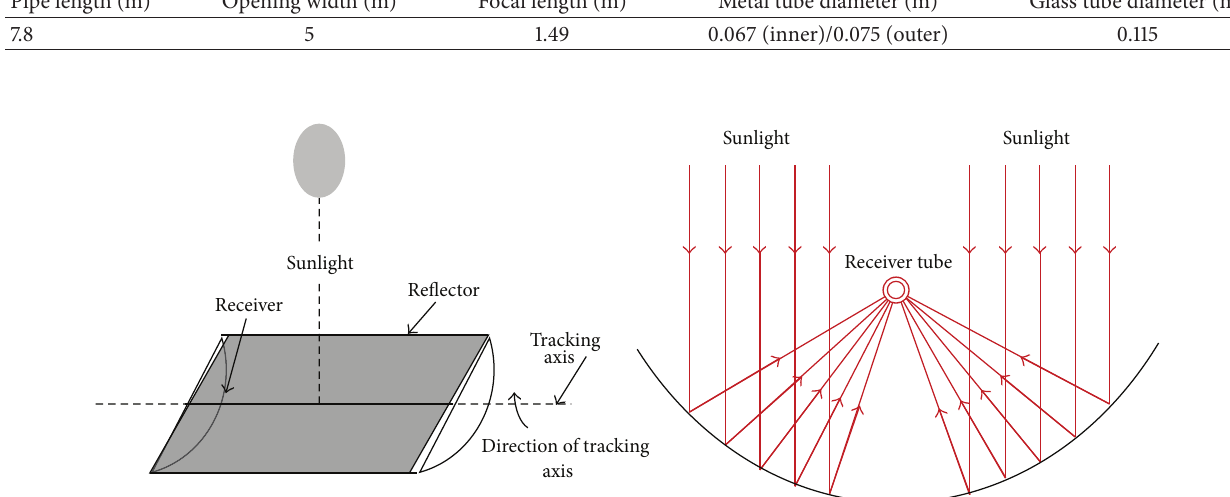
Figure 1: The main view and the axial diagram of the